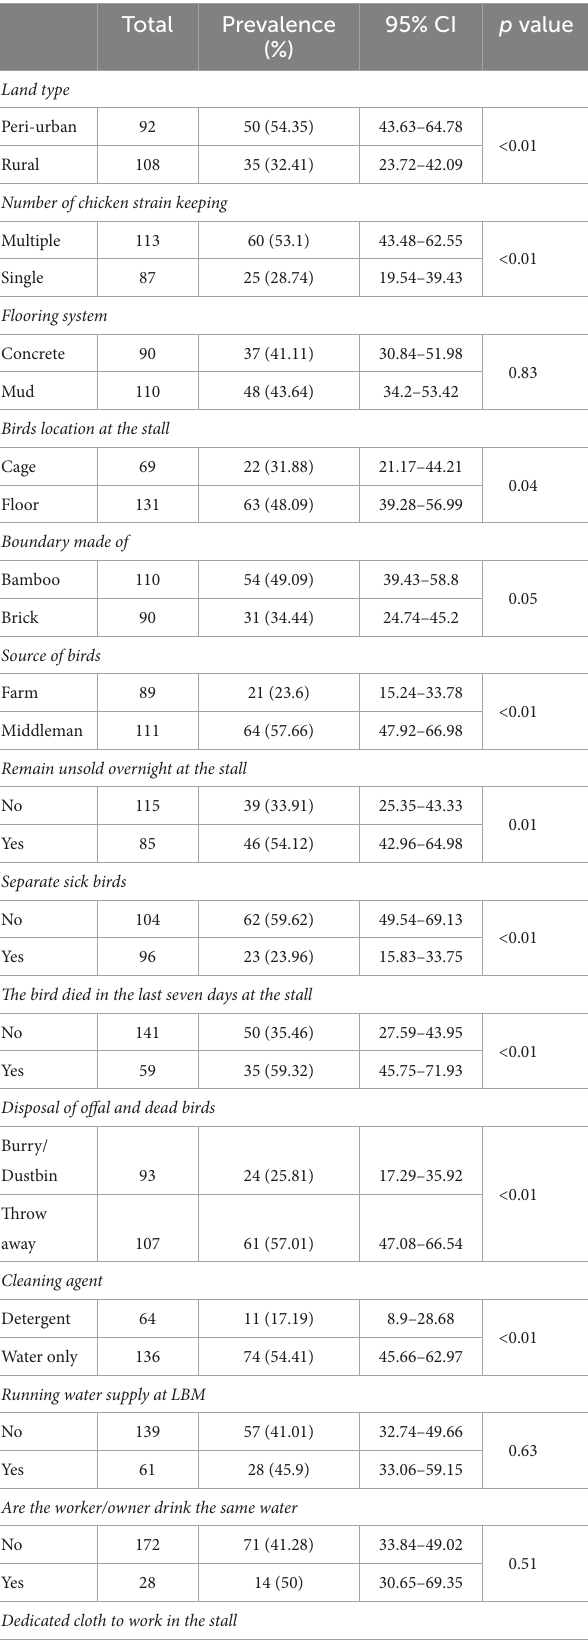
TABLE 2 Univariable analysis of factors to check association with AIV circulation (results from Pearson’s chi-square